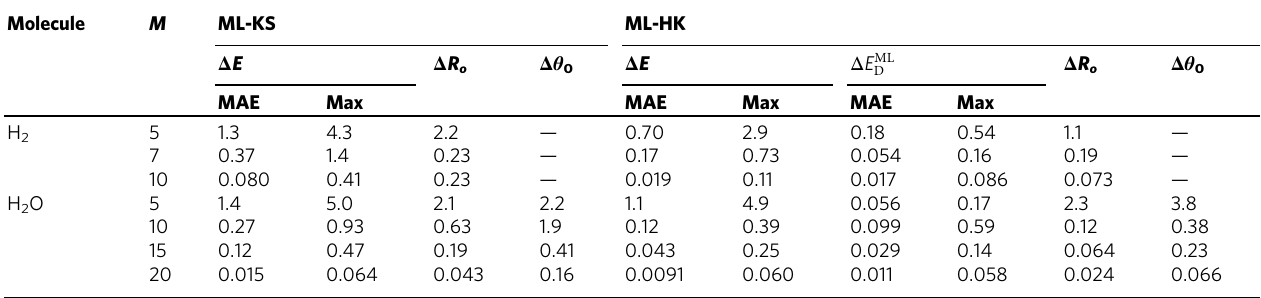
Table 2 Prediction errors on H 2 and H 2 O Molecule